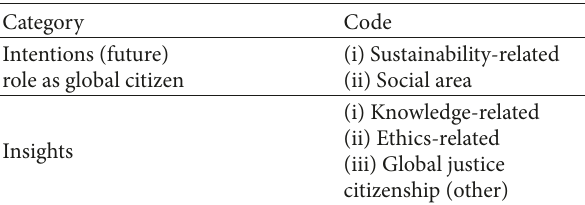
Table 5: Overview of codes for each category